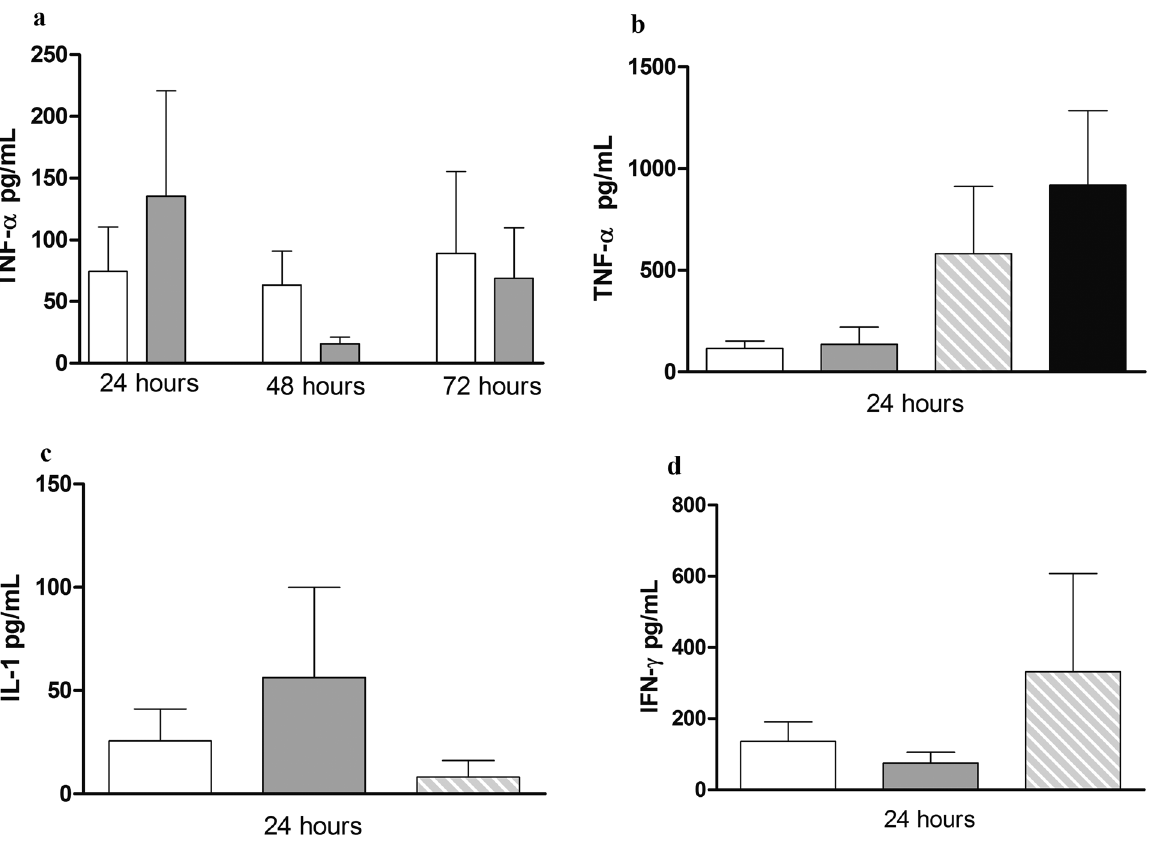
Figure 3 - Effect of U. diversum intrauterine infections in A/J mice. A/J mice were infected intravaginally by U. diversum and euthanized 24, 48 or 72 hours after infection. The uterus was macerated in medium RPMI centrifuged and the supernatant were used for measurement of cytokines (IL-1 β , TNF- α , IFN- γ ) by ELISA. a . TNF- α twenty four, 48 and 72 hours. b . TNF- α twenty four hours. c . IL-1 twenty four hours. d . IFN- γ twenty four- hours. n